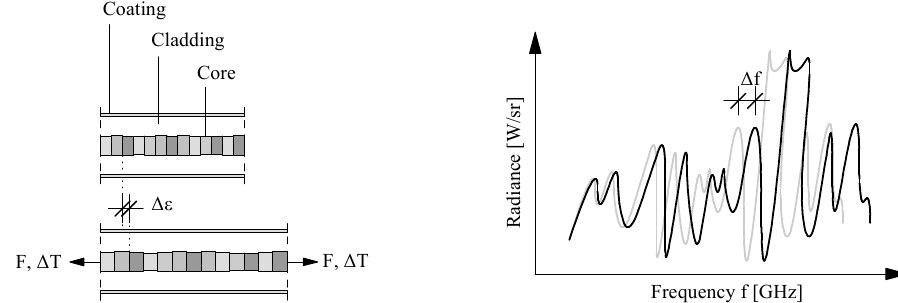
Fig. 1 Left: Longitudinal section through the glass fiber sensor with a characteristic profile of the refractive indices under force F and temperature  T induced stress. Right: Shift of the frequency pattern when the glass fiber is stretched.